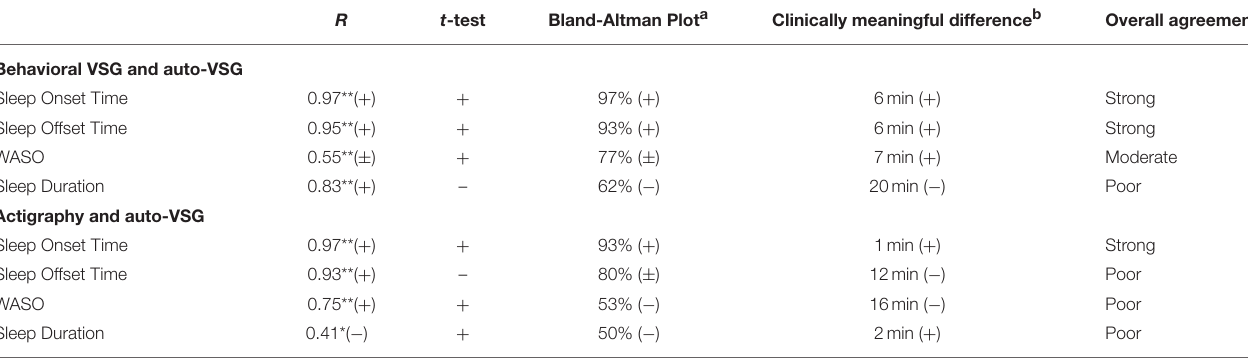
r, correlation, t-test results summarized in Table 3 , a % of sample correctly estimated within the upper and lower bound thresholds, see Bland-Altman plots, b average difference across methods, * p < 0.05, ** p <